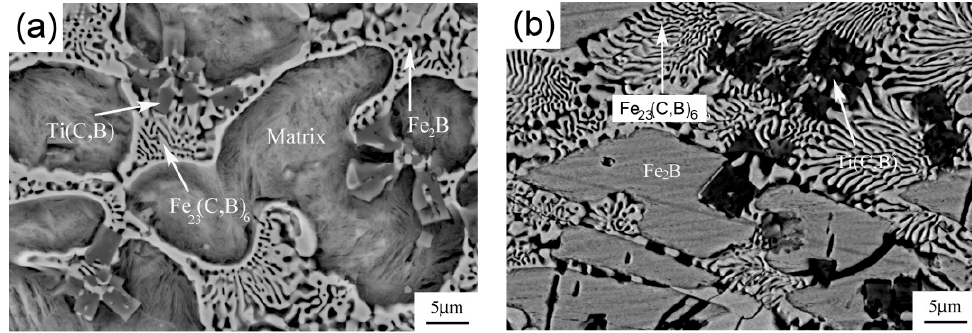
Figure 3. SEM images of the surface of the hardfacing layers with ( a ) 1.71% B and ( b ) 6.85% B.